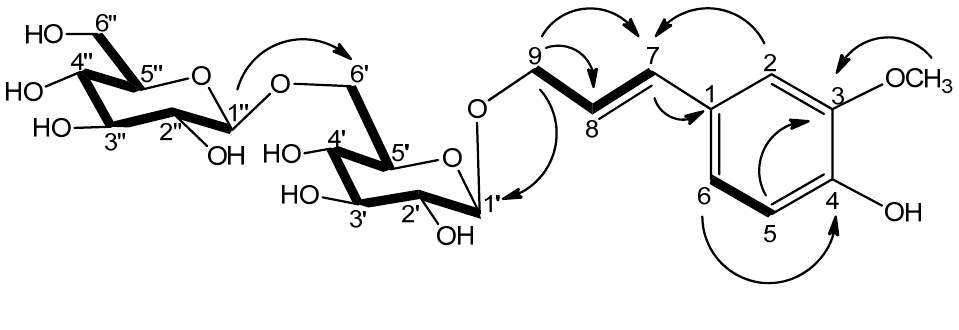
Figure 2. 1 H- 1 H COSY (bold lines) and key HMBC correlations (H → C) of 1